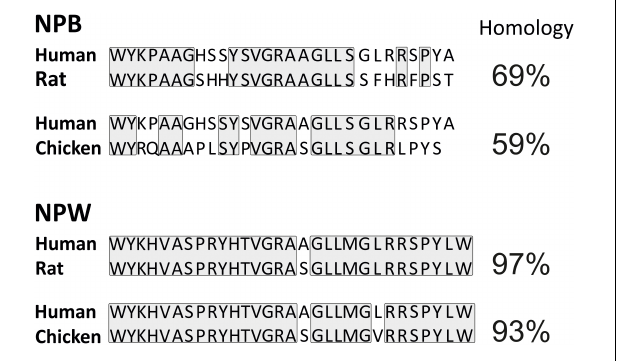
FIGURE 1 | Comparison of amino acid sequence of human, rat, and chicken NPB and NPW peptides. Amino acid residues with identical sequences in compared species are